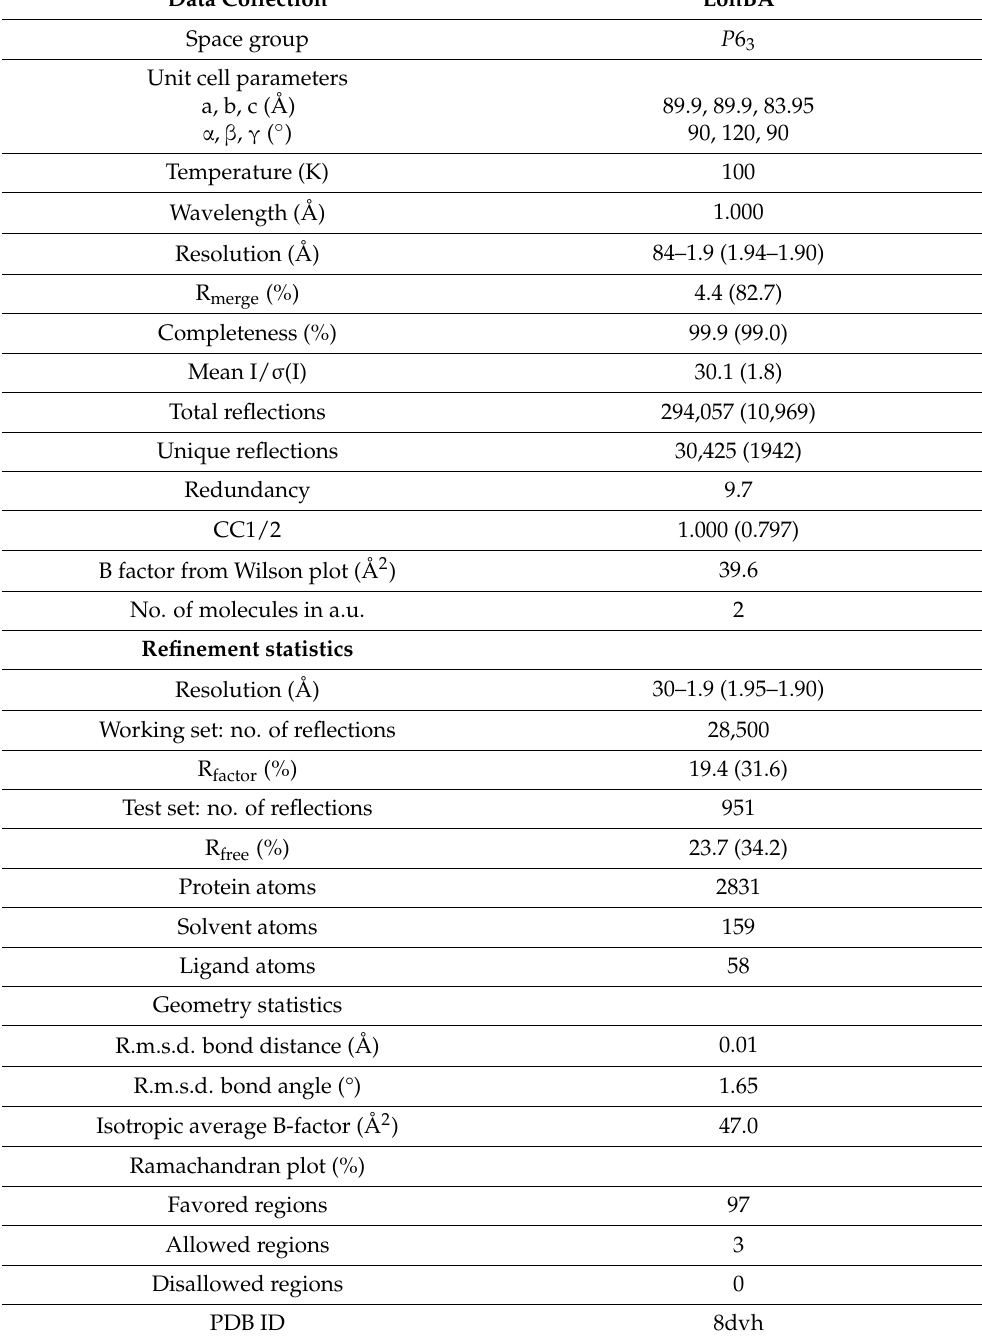
Table 1. Data collection and refinement